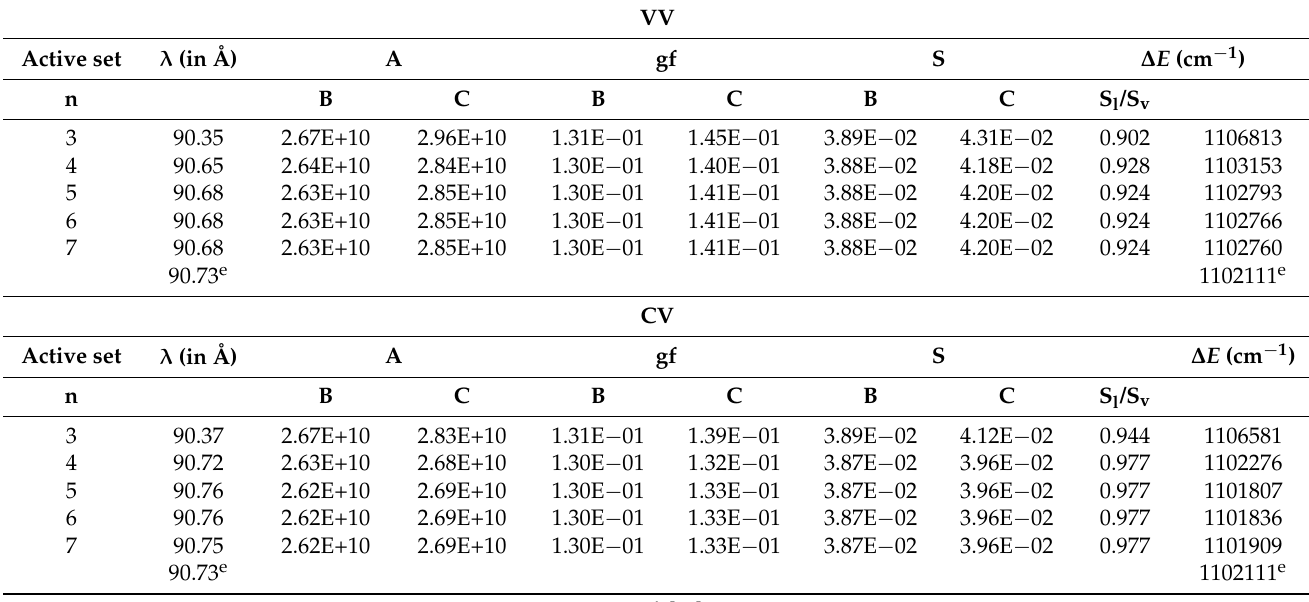
Table 3. Convergence of the radiative data and transition energy between the 2s 2 2p 2 P ˝ 1/2 and 2s2p 2 2 D 3/2 levels of B-like